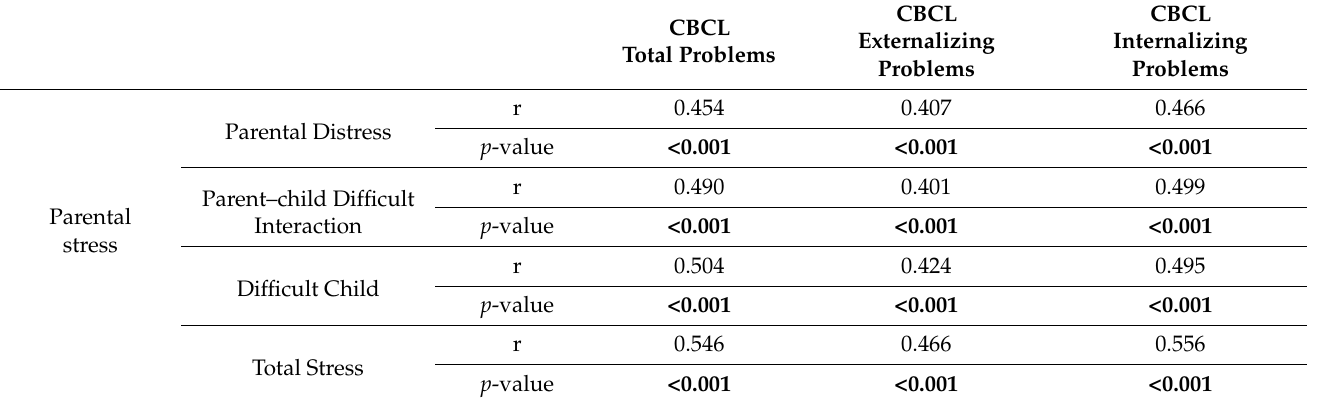
Table 4. Spearman correlation analysis between Child Behavior Checklist and Parental Stress